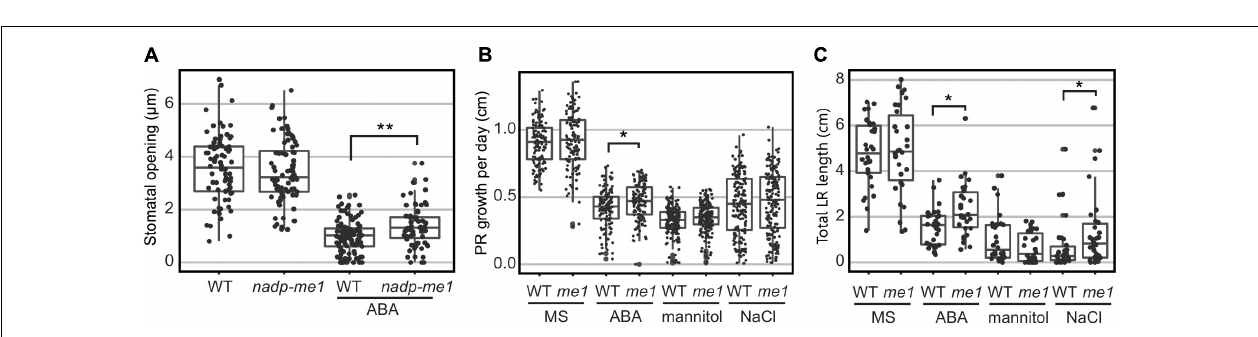
FIGURE 4 | Stomatal opening and root length assays in nadp-me1 mutant. (A) Stomata pore size was determined in the light and in the presence or absence of 30 µ M ABA. Primary (PR, B ) and lateral (LR, C ) root length were assayed in seedling transferred to MS plates supplemented with 10 µ M ABA, 100 mM NaCl, or 225 mM mannitol for 6 days. Between 70 and 100 stomata, 30 primary roots, and 120–160 secondary roots per line and condition were measured. All values are presented and the statistical descriptions of each set of data are shown as box plots. One ( p < 0.05) or two ( p < 0.001) asterisks denote significant differences between WT and nadp-me1 according to t -test or Mann-Whitney rank sum test for data that passed or fail normality test and equal variance test, respectively.